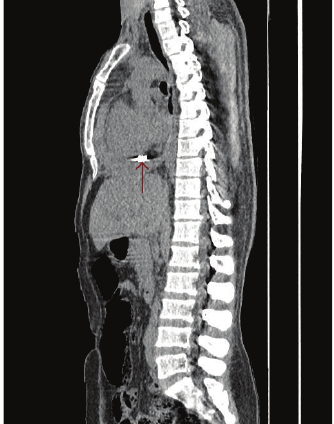
Figure 3: Sagittal cut view of chest CT shows a bullet in the pericardial sac with pericardial